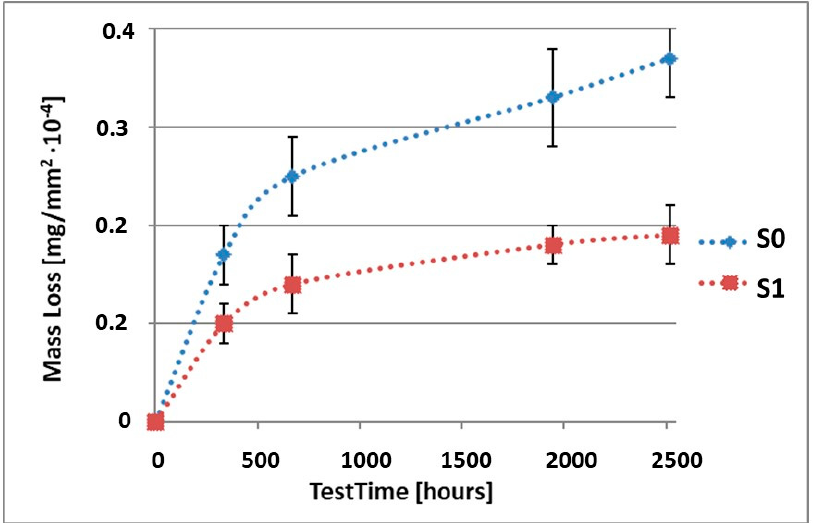
Figure 1. Comparison of the mass losses of samples S0 and S1 for tests in NSS environment.